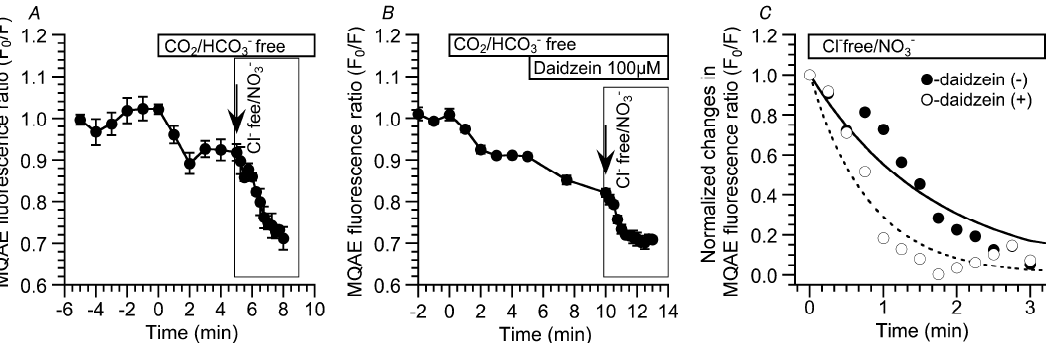
Figure 5. Enhancement of Cl − efflux stimulated by daidzein. Experiments were carried out under the CO 2 /HCO 3 − -free condition. ( A ) Decreases in the MQAE fluorescence ratio (F 0 /F) induced by the Cl − -free NO 3 − solution in the absence of daidzein. The value of F 0 /F just before the switch to the Cl − -free NO 3 − solution was 0.91 ± 0.02 ( n = 3). The switch to the Cl − -free NO 3 − solution decreased F 0 /F (F 0 /F 2.5 min after the switch = 0.73 ± 0.02, n = 3). The value of F 0 /F plateaued within 2.5 min. ( B ) Decreases in the MQAE fluorescence ratio (F 0 /F) induced by the Cl − -free NO 3 − solution in the presence of daidzein. The value of F 0 /F just before the addition of daidzein was 0.91 ± 0.01 ( n = 3). Stimulation with 100 µ M of daidzein further decreased F 0 /F (F 0 /F 5 min after the stimulation = 0.83 ± 0.01, n = 3). Switch to the Cl − -free NO 3 − solution decreased F 0 /F (F 0 /F two min after the switch = 0.70 ± 0.02, n = 3). The value of F 0 /F reached a plateau within two min. ( C ) The time courses of F 0 /F decrease in the presence and the absence of daidzein. The normalized F 0 /Fs and fitted curves were plotted. The decreases in F 0 /F were fitted to an exponential curve, a · [exp( − t/ τ )] (where a is the value at t = ∞ in each experiment, t is the time after procaterol stimulation, and τ is the time constant). Daidzein stimulation decreased τ from 1.70 ± 0.08 min ( n = 3) to 0.81 ± 0.11 min ( n = 3). Thus, daidzein stimulation accelerated the decreases in [Cl − ] i induced by the Cl − -free NO 3 − solution, indicating that daidzein stimulates Cl − efflux.